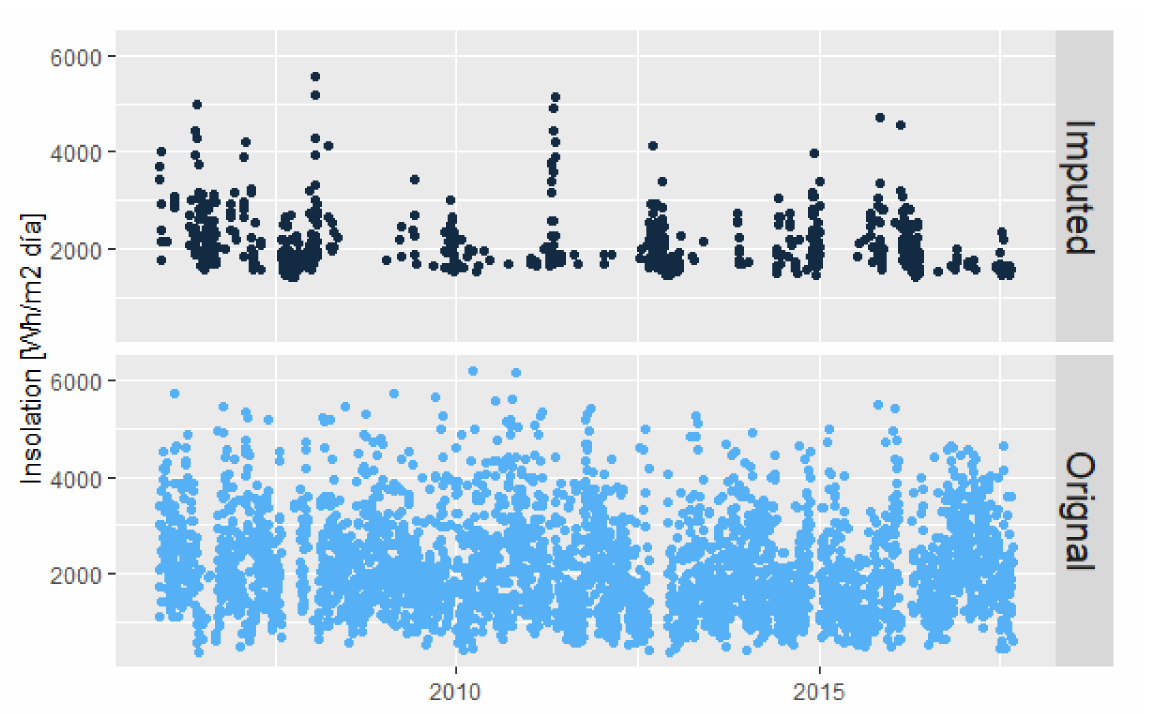
Figure 14. Cerro P á ramo